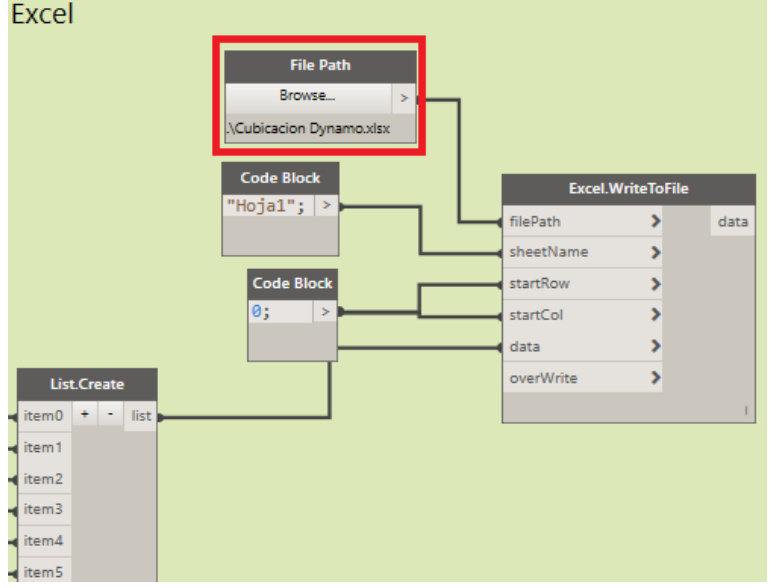
Figure A12. Calculations of the printing material.